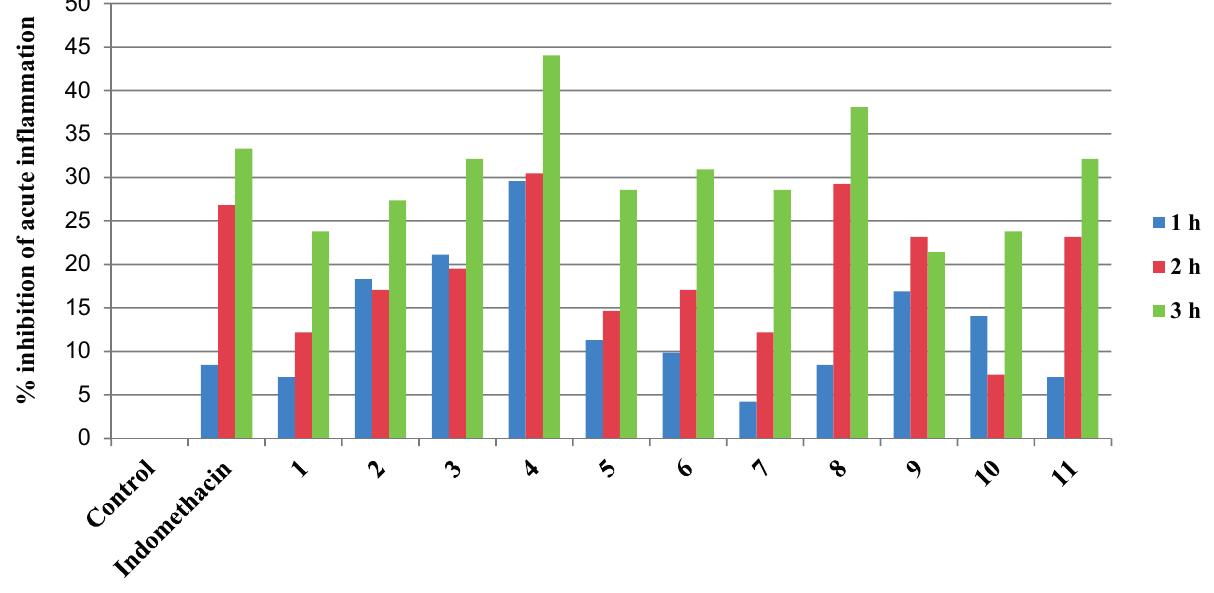
Figure 1. % Inhibition of acute inflammation (carrageenan-induced paw edema), ( n =